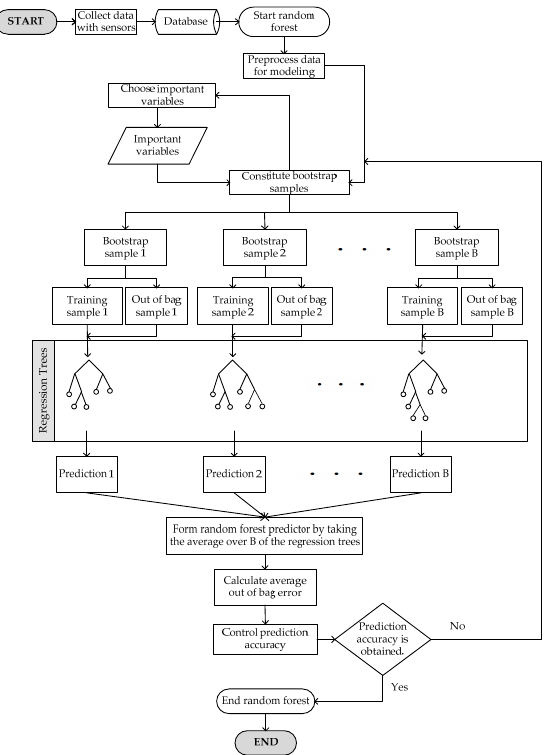
Figure 6. Flowchart of random forests.